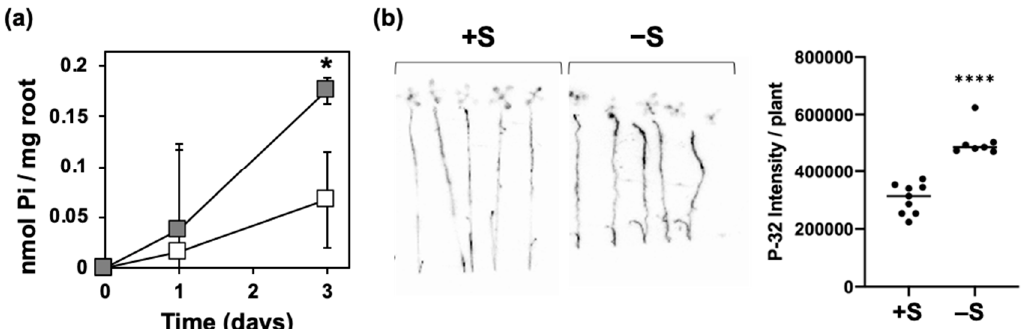
Figure 2. Increased Pi uptake under –S. Wild-type (WT) plants were used. In ( a ), fifteen-day-old plants were transferred to hydroponic media supplemented with 1500 µ M sulfate ( + S) for 2 days before starting the treatment. For the treatment, plants were transferred to hydroponic media with ( + S, white color) or without (–S, gray color) sulfate. Pi uptake was calculated as described in the Materials and Methods section. In ( b ), plants were grown for 10 days on MGRL agar media supplemented with 1500 µ M ( + S) or 15 µ M sulfate (–S). Plants were then transferred to + S or –S hydroponic medium containing 32 P for 60 min. Bars and error bars indicate mean ± SE (for ( a ): n = 3, for ( b ): n = 7–8). Asterisks indicate significant di ff erences between + S and –S detected by Student’s t -test (* p < 0.05) for ( a ) and Welch’s t -test (**** p < 0.0001) for ( b ).